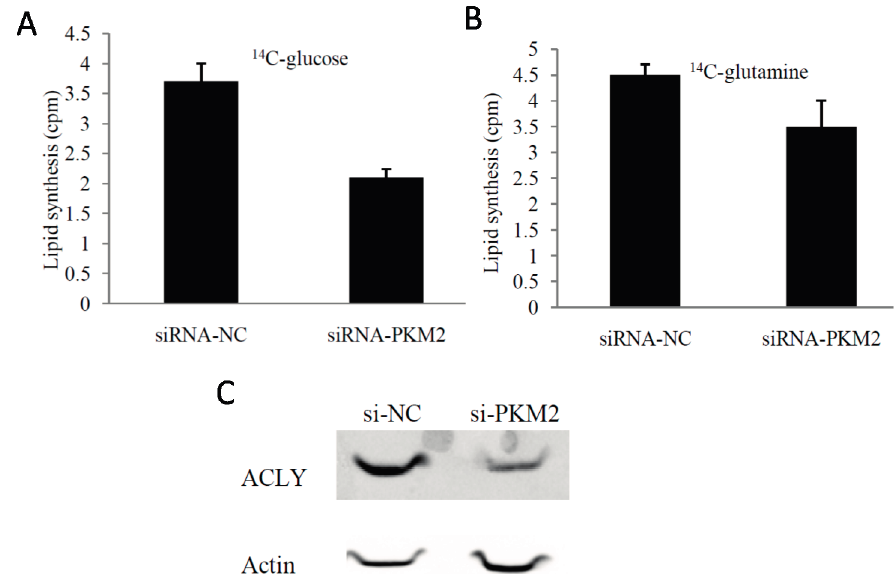
Figure 5. Effects of PKM2 -knockdown by transient RNAi transfection on lipid synthesis. ( A ) PKM2-knockdown inhibited the glucose-dependent lipid synthesis; ( B ) PKM2